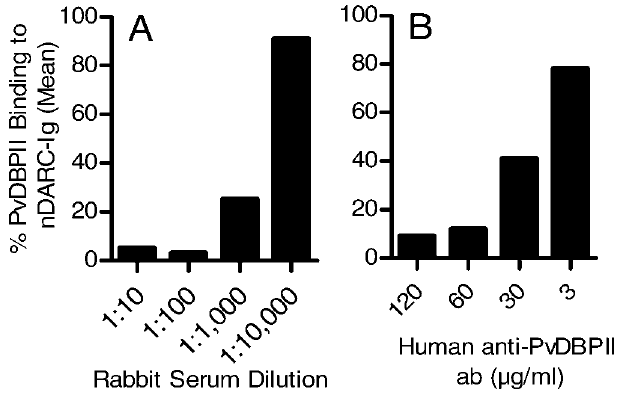
Figure 1. Inhibition of nDARC-Ig Binding to rPvDBPII by Antibodies Rabbit (A) and human (B) anti-PvDBPII Ab were tested to observe inhibition of the interaction of the rPvDBPII protein and the N-terminal region of Duffy in the nDARC-Ig chimera. In ELISA-based nDARC-Ig assays, bars indicate the mean binding percentage relative to pre-bleed rabbit serum or nonspecific human IgG (120 l g/ml). Duplicate experi- ments showed variation of , 5%.